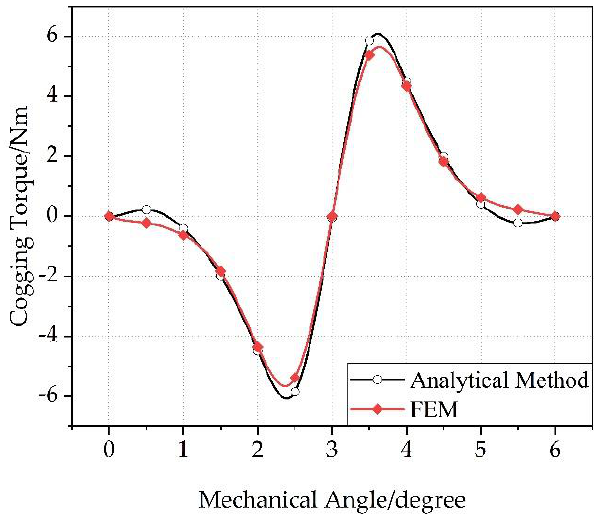
Figure 14. Comparison of analytical solutions and finite element solutions.